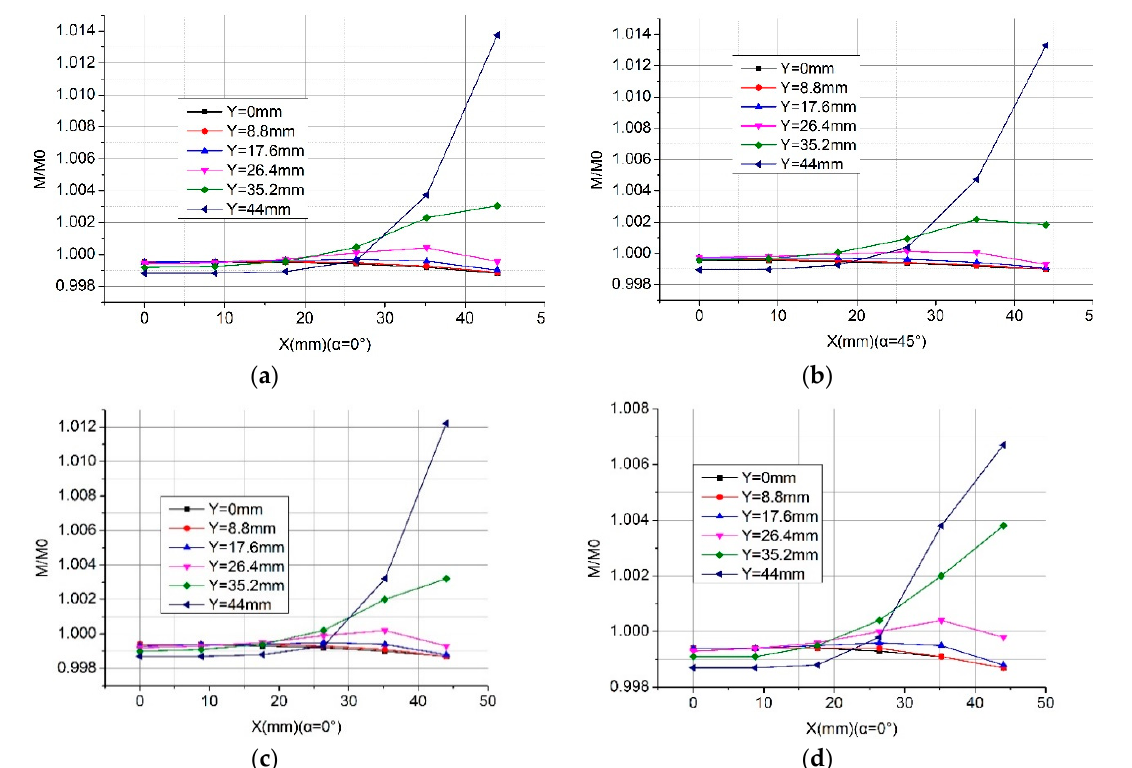
Figure 19. Calculation results of the normalized mutual inductance between the Rogowski coil of the rectangular skeleton and the long straight primary conductor. ( a ) Skeleton with an arc angle and the primary conductor ( α = 0°; 𝑟 (cid:3030) = 13.369 mm ); ( b ) skeleton with an arc angle and tilt angle of the primary conductor ( α = 45°; 𝑟 (cid:3030) = 13.369 mm ); ( c ) skeleton with an arc angle and the primary conductor ( α = 0°; 𝑟 (cid:3030) = 15.9155 mm ); ( d ) skeleton with an arc angle and the primary conductor ( α = 0°; 𝑟 (cid:3030) = 22.2817 mm ).